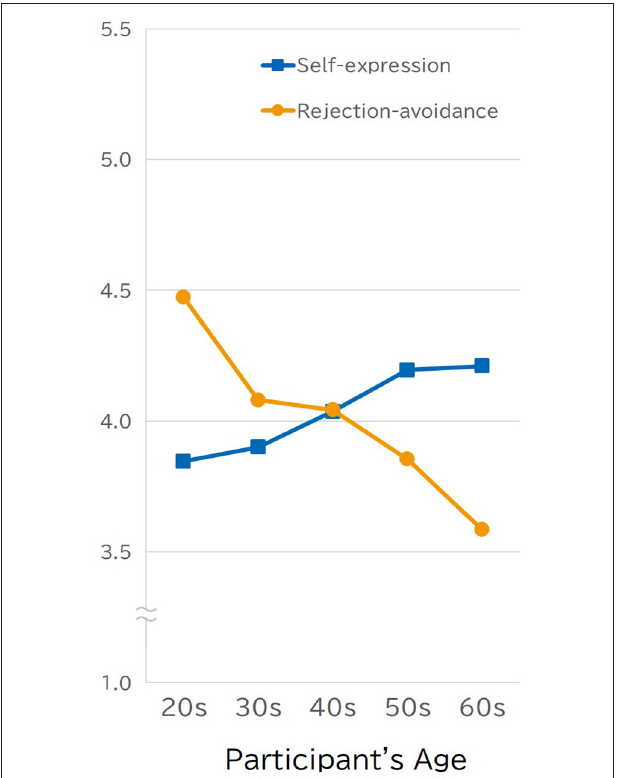
FIGURE 1 | Positive correlation between the scores of self-expression and the respondents’ age and negative correlation between the rejection-avoidance and the respondents’ age (Study